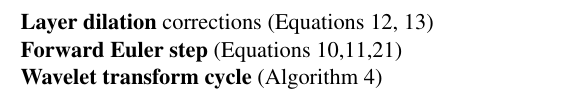
Algorithm 2 Explicit Runge–Kutta sub-cycles (see Equation 21). The steps below are repeated three times for RK3 and four times for RK4.